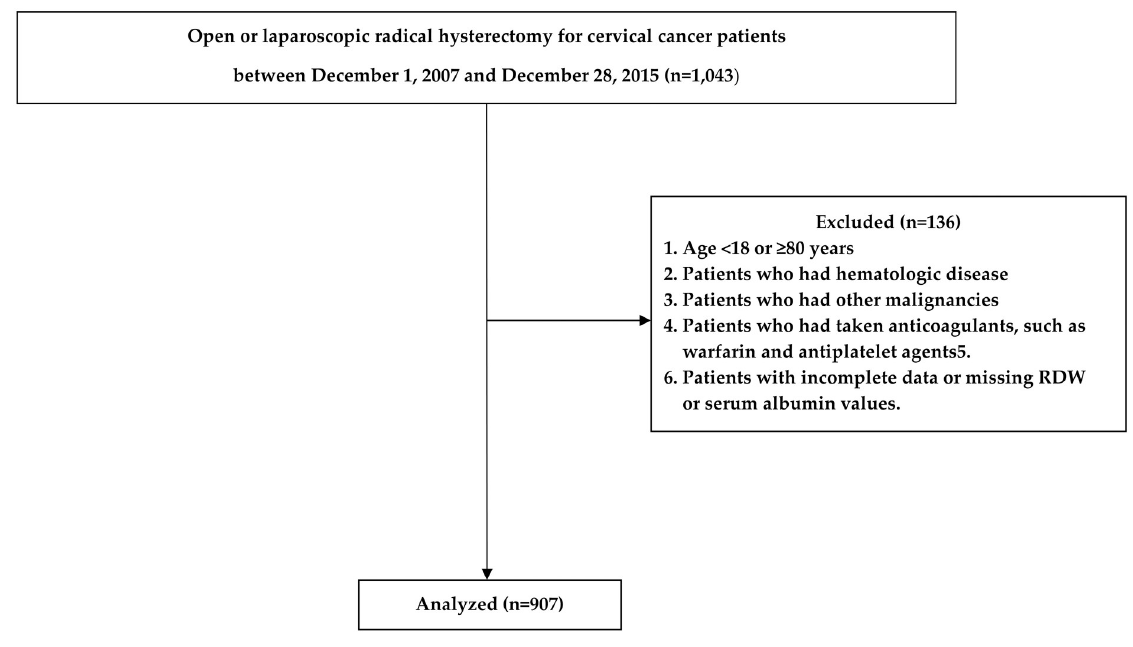
Fig 1. Flowchart of the retrospective